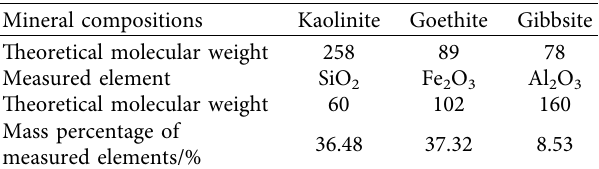
Table 5: Content of element and molecular weight of S-4. Mineral compositions Kaolinite Theoretical molecular